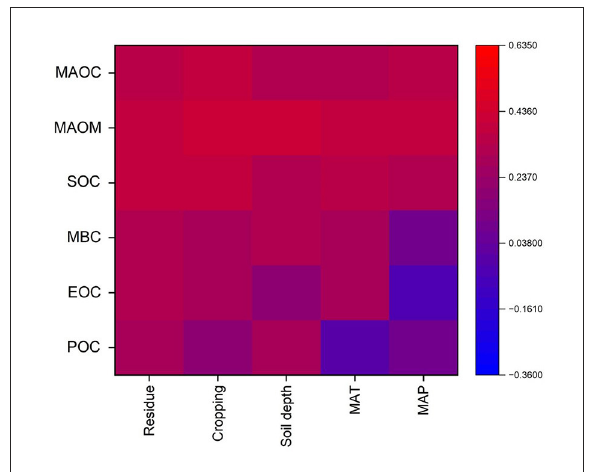
FIGURE9 The Pearson correlations between the response ratio (conservation tillages (NT, RT) vs. conventional tillage) of soil fractions including mineral-associated organic carbon (MAOC) and mineral-associated organic matter (MAOM), soil organic carbon (SOC), microbial biomass C (MBC), easily oxidized organic carbon (EOC) and particulate organic carbon (POC) under different types of land use (Cropping pattern, residue management, CT, NT and RT) and climatic factors such as MAP and MAT. Correlation coefficients have designated by the color